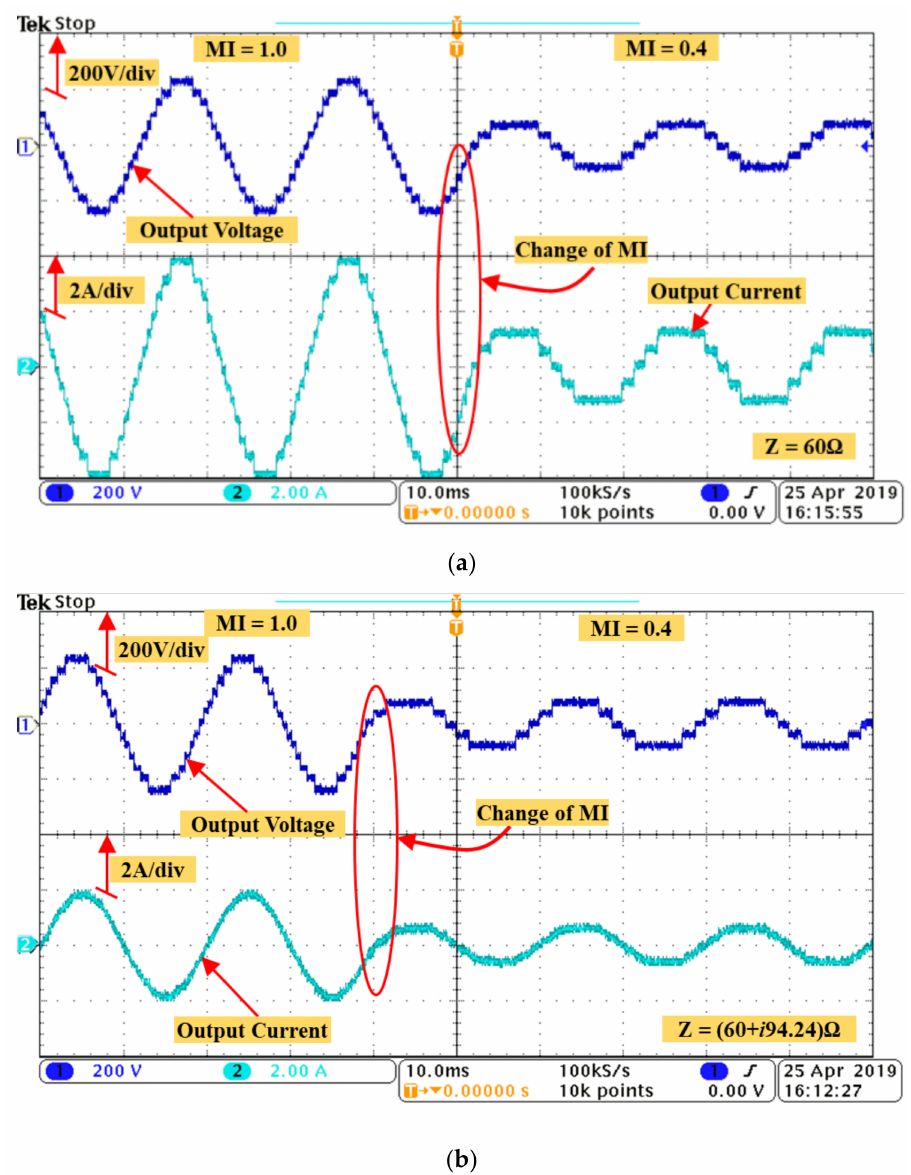
Figure 11. Terminal voltage and Load current with a change of MI with ( a ) R load and ( b ) R-L